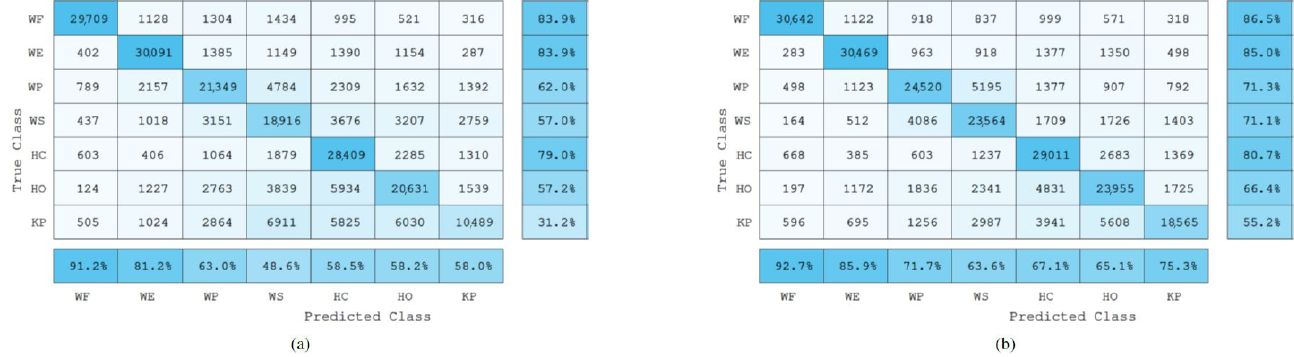
Figure 12. MLP networks confusion matrices of the seven gestures collected using EMG data only ( a ), and EMG and IMU data ( b ) from all testing subjects. The numbers inside each cell represent the number of sample points classified. The last row from each confusion matrix represents the precision score percentages of each class. Similarly, the last column represents the recall score percentages of each